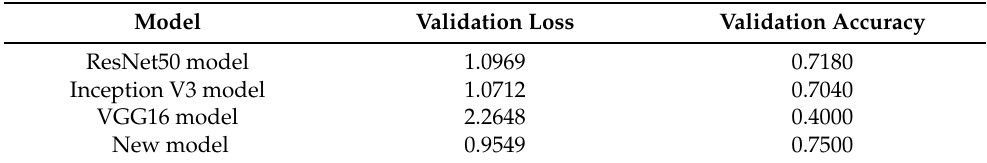
Table 7. Validation accuracy and the validation loss of noisy 100 Sports Image Classification dataset performed with four different classification models.